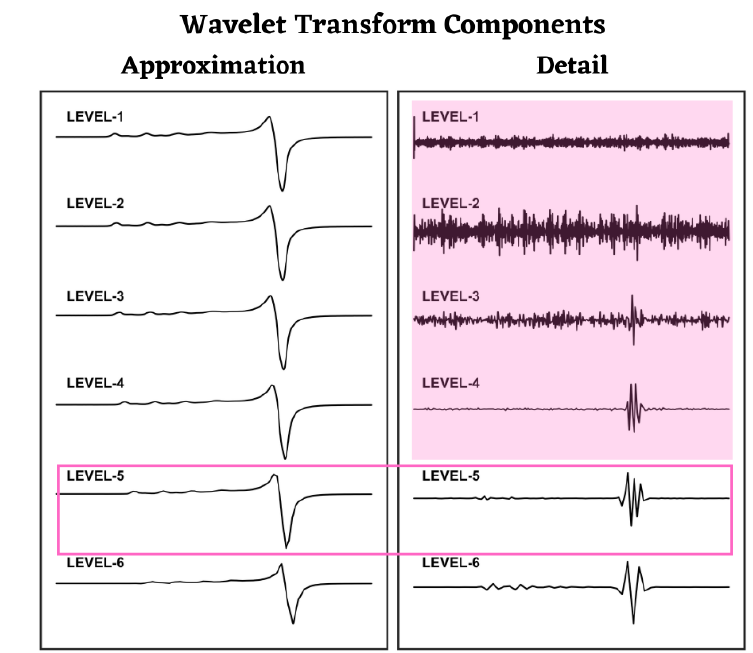
Figure 5. Cw-ESR spectrum (light grey) of a Cu(II)-N 4 complex (inset) and its wavelet transform super-hyperfine (shf) component (black) are shown in the top panel. The bottom panel shows the Approximation and Detail components of the analysis for level-1 to level-6, the optimal level of decomposition being level-5 (magenta box). From level-1 to -4, the Detail component was removed from the signal at each level of analysis. The values of g (cid:107) and g ⊥ were calculated to be 2.42 and 2.10, respectively, while A (cid:107) ( Cu ) and A ⊥ ( Cu ) were found to be 122.0 ± 2 G and 28.0 ± 1.0 G. The nitrogen super-hyperfine splitting constants, A (cid:107) ( N ) = 19.8 ± 0.2G and A ⊥ ( N ) = 18.8G, were also